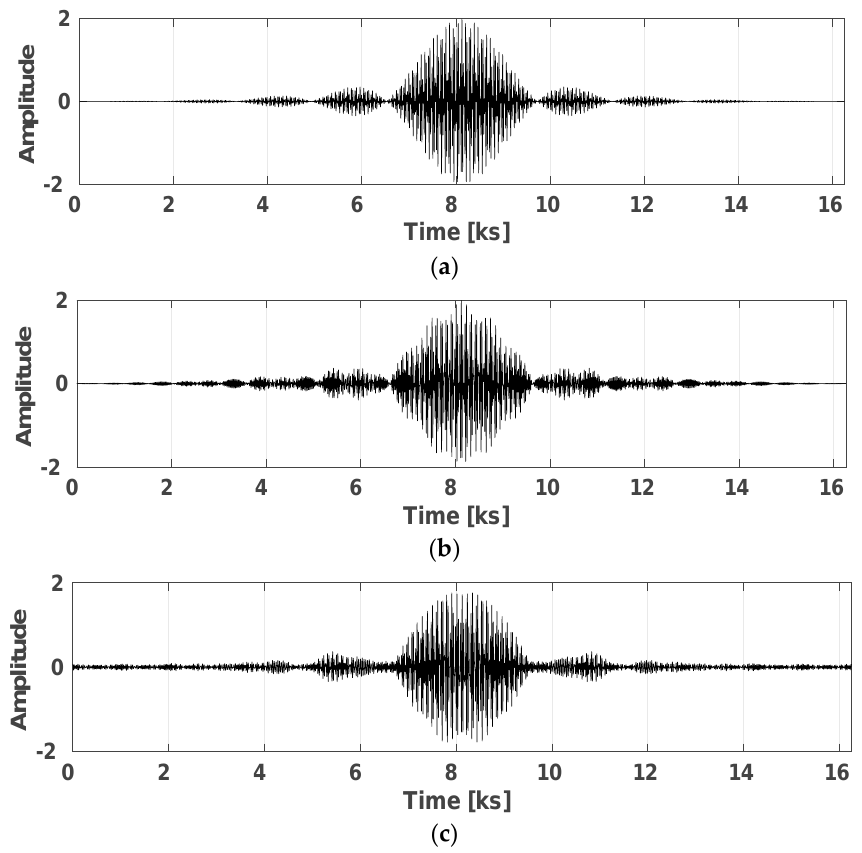
Figure 4. Reconstruction of the sparse modulated by random carrier frequencies for ( a ) input signal, ( b ) reconstruction signal by MATLAB, and ( c ) reconstruction signal by high-level synthesis (HLS) for 16- and 32-bit data precision.